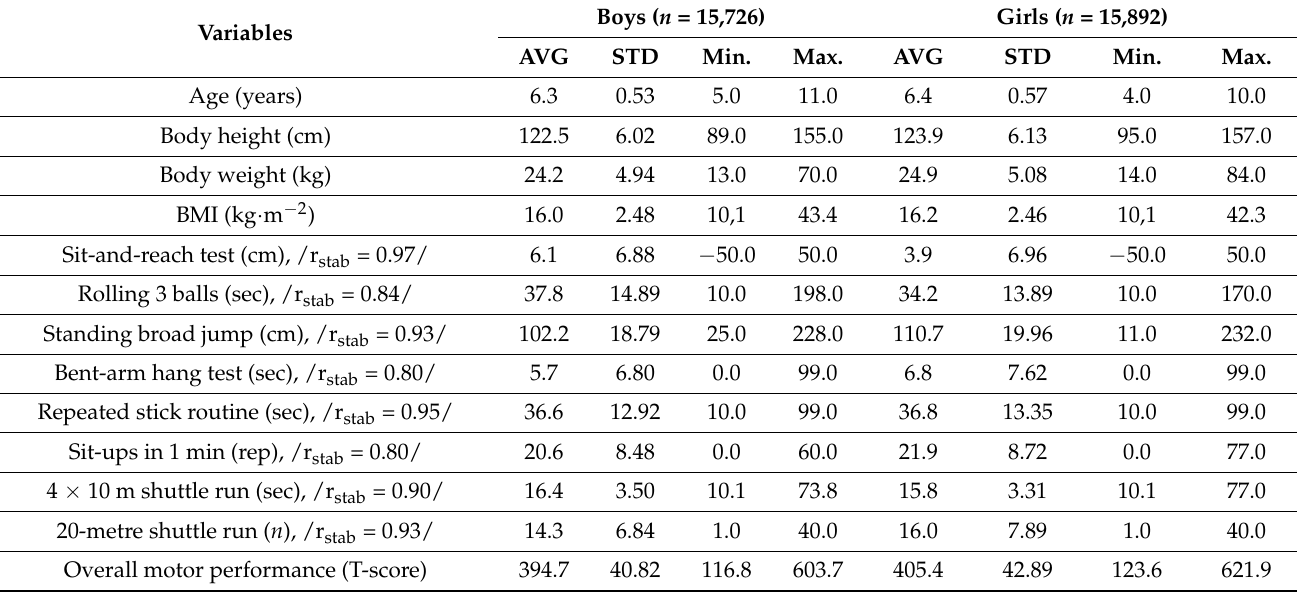
Table 1. Descriptive characteristics of the sample—boys and girls separately.